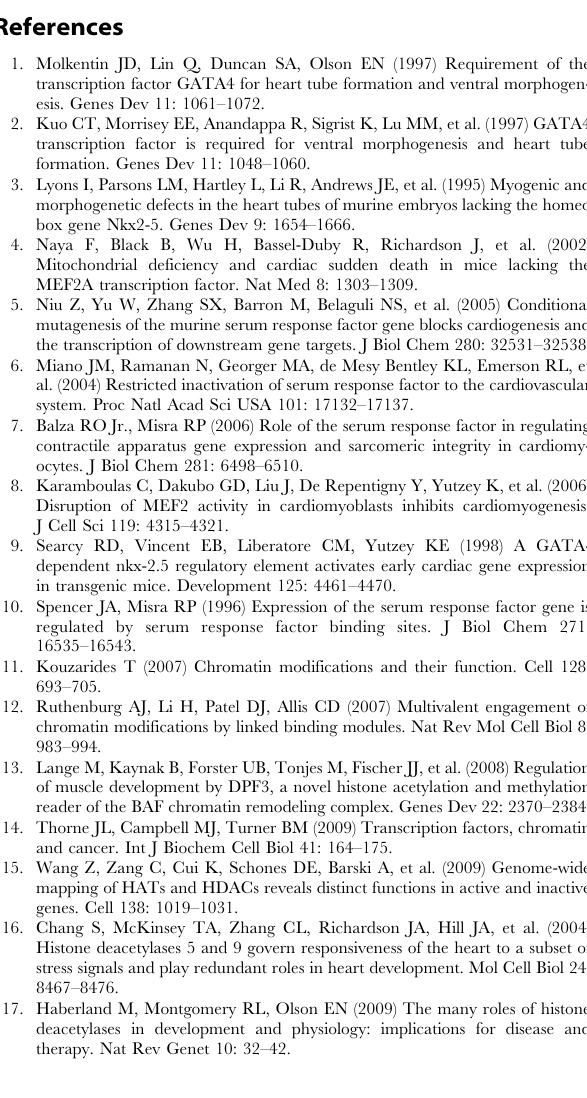
Table S17 Gata4, Mef2a, Nkx2.5, and Srf differentially expressed genes (Ensembl v45) using duplicates of two different siRNAs.